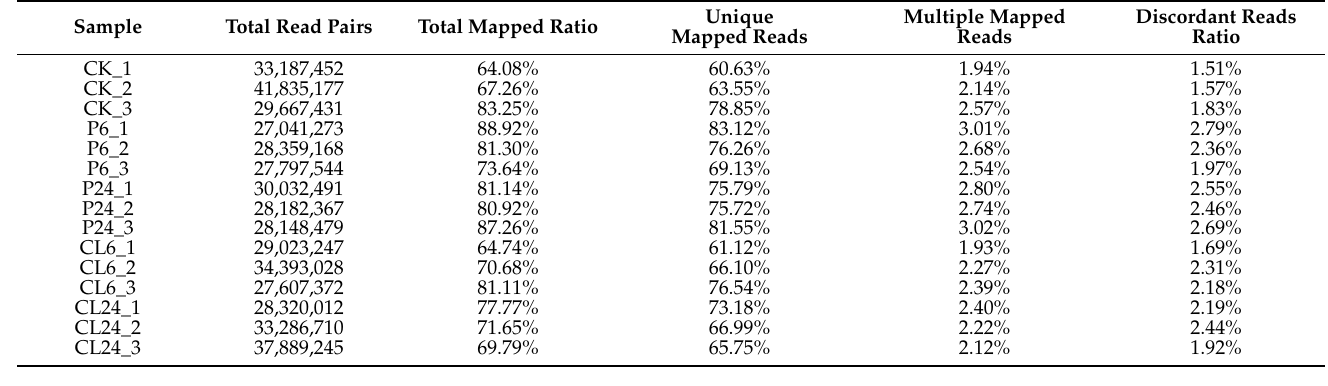
Table 2. Comparison of reads and reference genome.